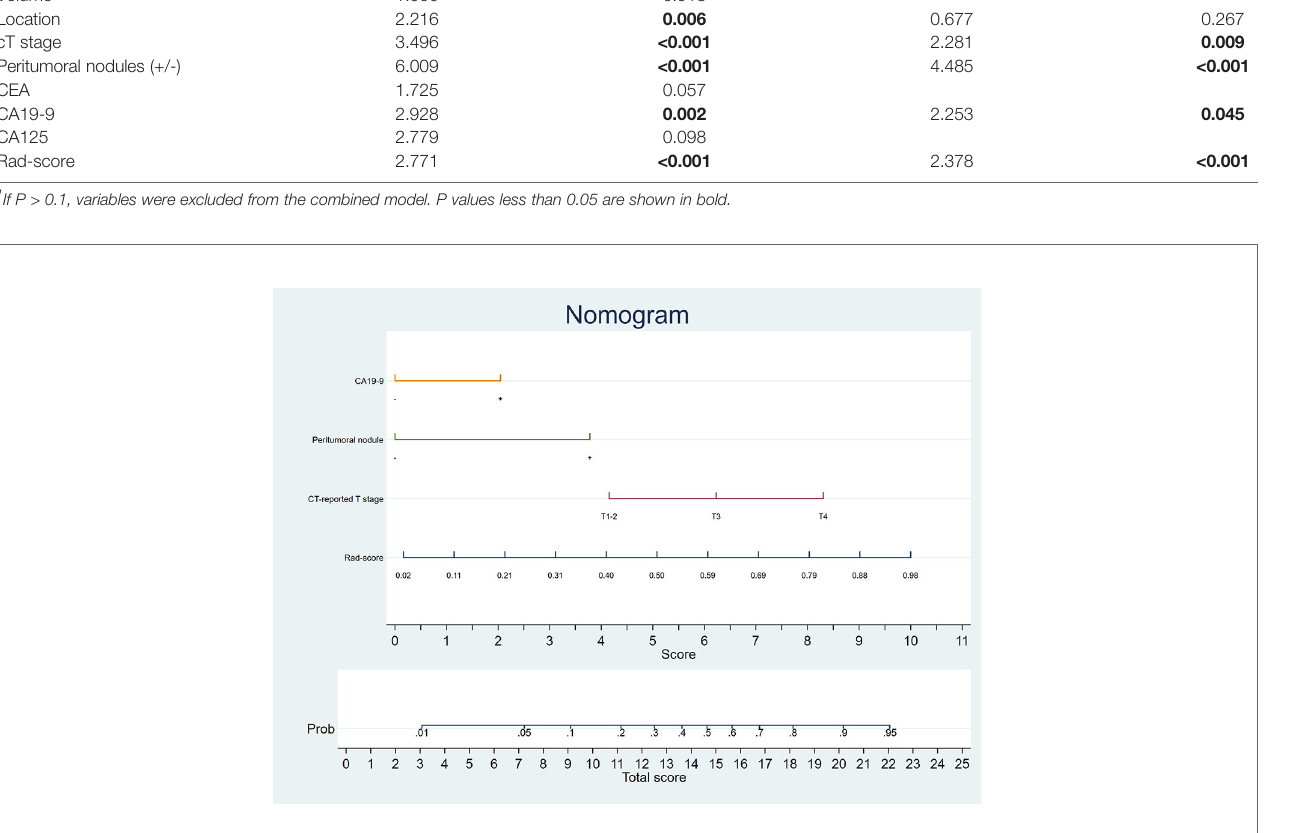
FIGURE 3 | Nomogram developed in the training